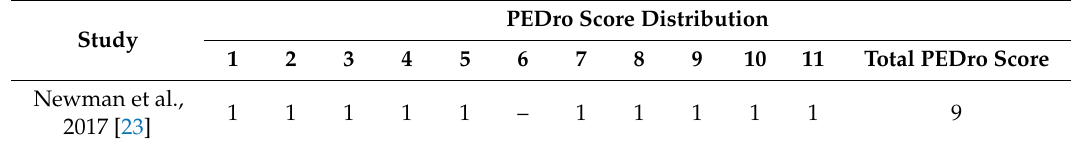
Table 1. PEDro score for randomized controlled trials and quasi-experimental studies.